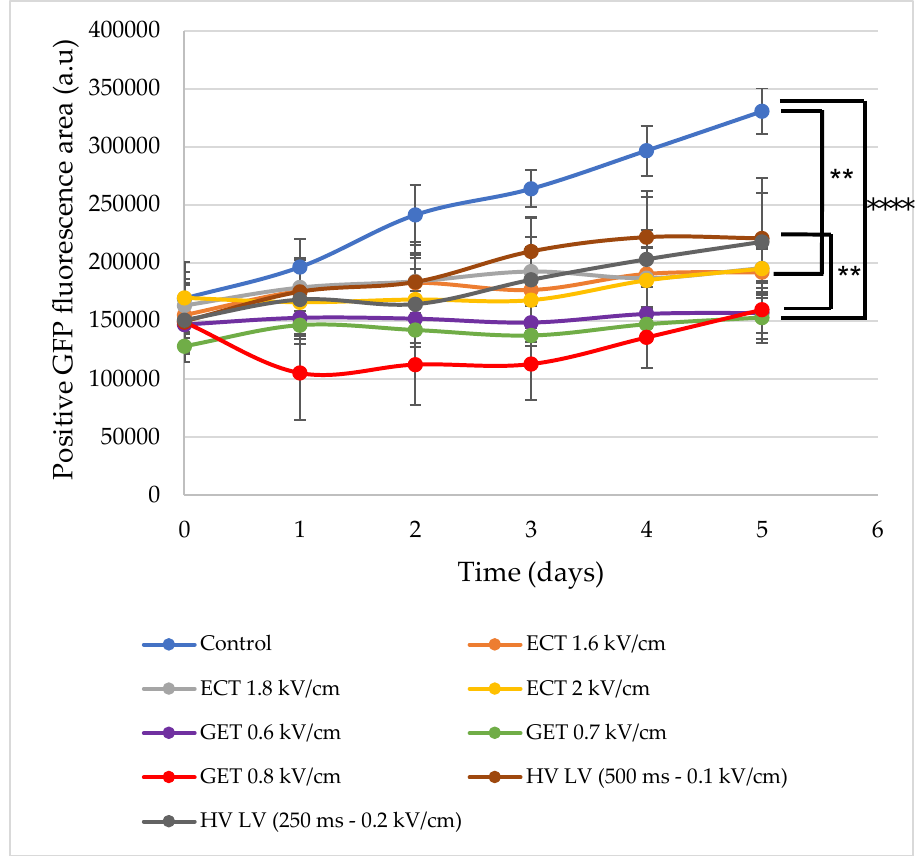
Figure 7. Multicellular spheroids growth as a function of time. Spheroids were pulsed with ECT pulse parameters (green, dark blue, purple curves) (8 pulses of 100 µ s at 1Hz with 1.6; 1.8 and 2 kV/cm), GET pulse parameters (gray, light blue, pink curves) (10 pulses of 5 ms at 1 Hz with 0.6; 0.7 and 0.8 kV/cm) and HV-LV (red and orange curves) with HV constant (100 µ s of 1 kV/cm) and LV variable (500 ms of 0.1 kV/cm and 250 ms of 0.2 kV/cm). Positive GFP fluorescence area (a.u.) was quantified every day during 5 days (expressed as mean +/ − SD). N = 6 spheroids per